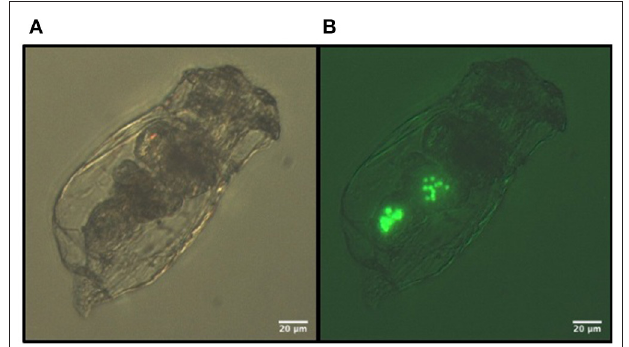
FIGURE 3 | Images of the 3 µ m fluorescent polystyrene MS ingested by B. calyciflorus : (A) bright light, (B) fluorescent light.